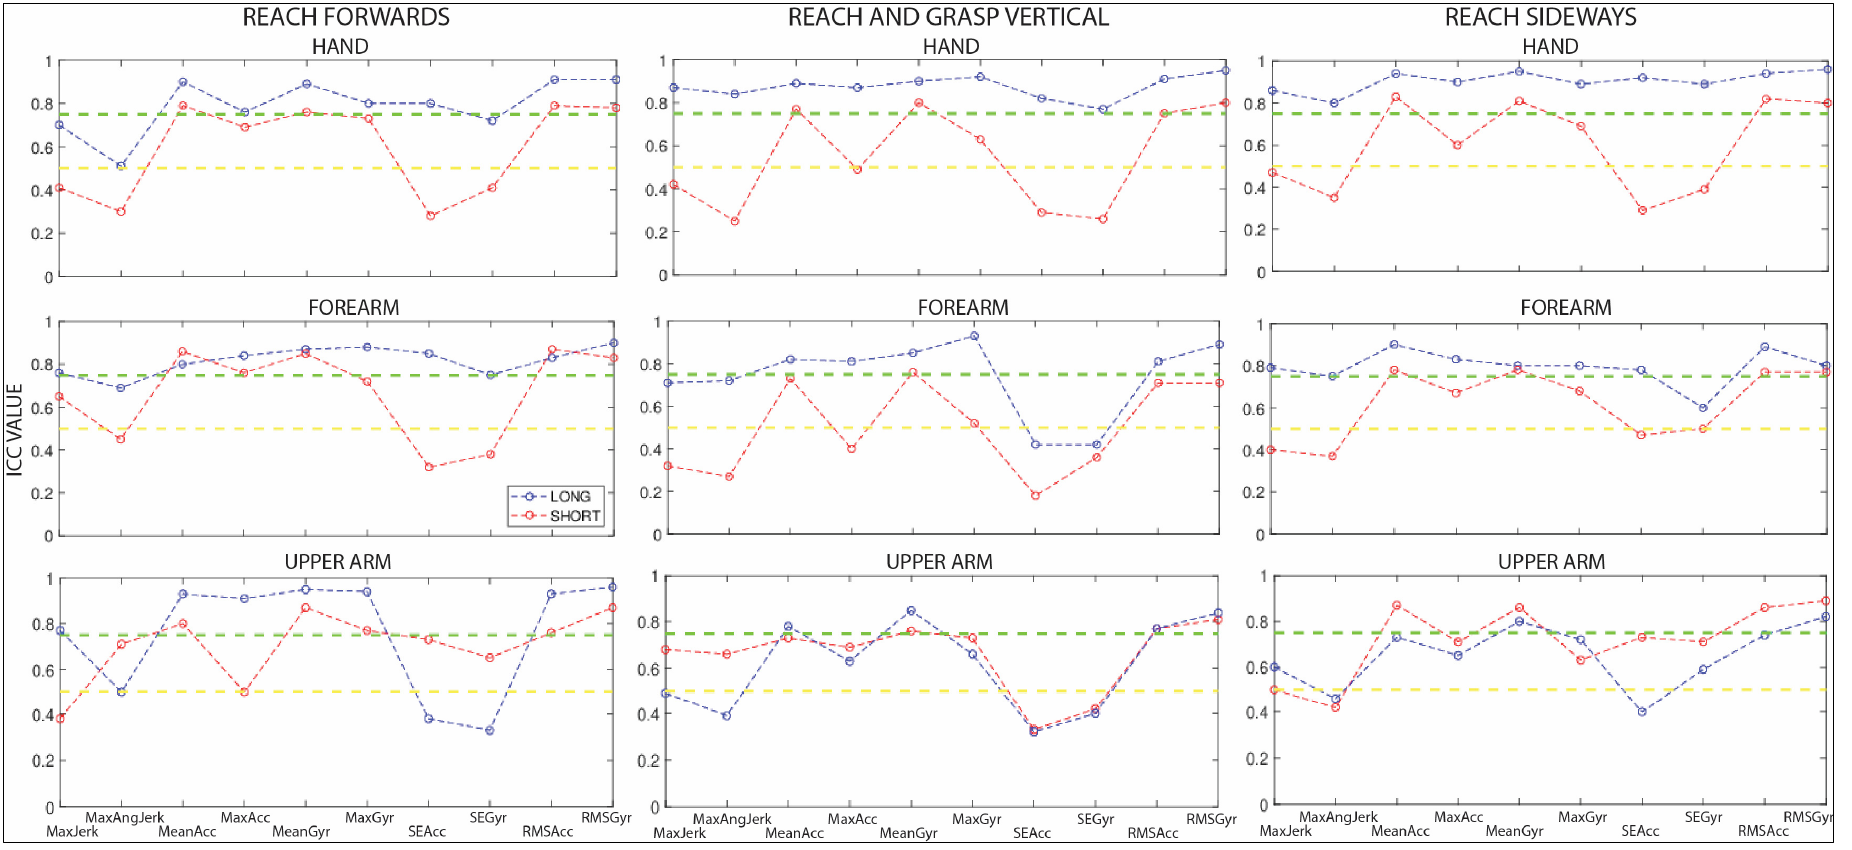
Figure 2. Within-session ICC values of the different sensor parameters for reach forwards, reach-and-grasp vertical, and reach sideways. The green and yellow dotted lines depict the limit of good and moderate correlations, respectively. Blue and red lines are for illustrative purposes. Acc = acceleration; Gyr = angular velocity; Max = maximal; RMS = root mean square; SE = sample entropy.